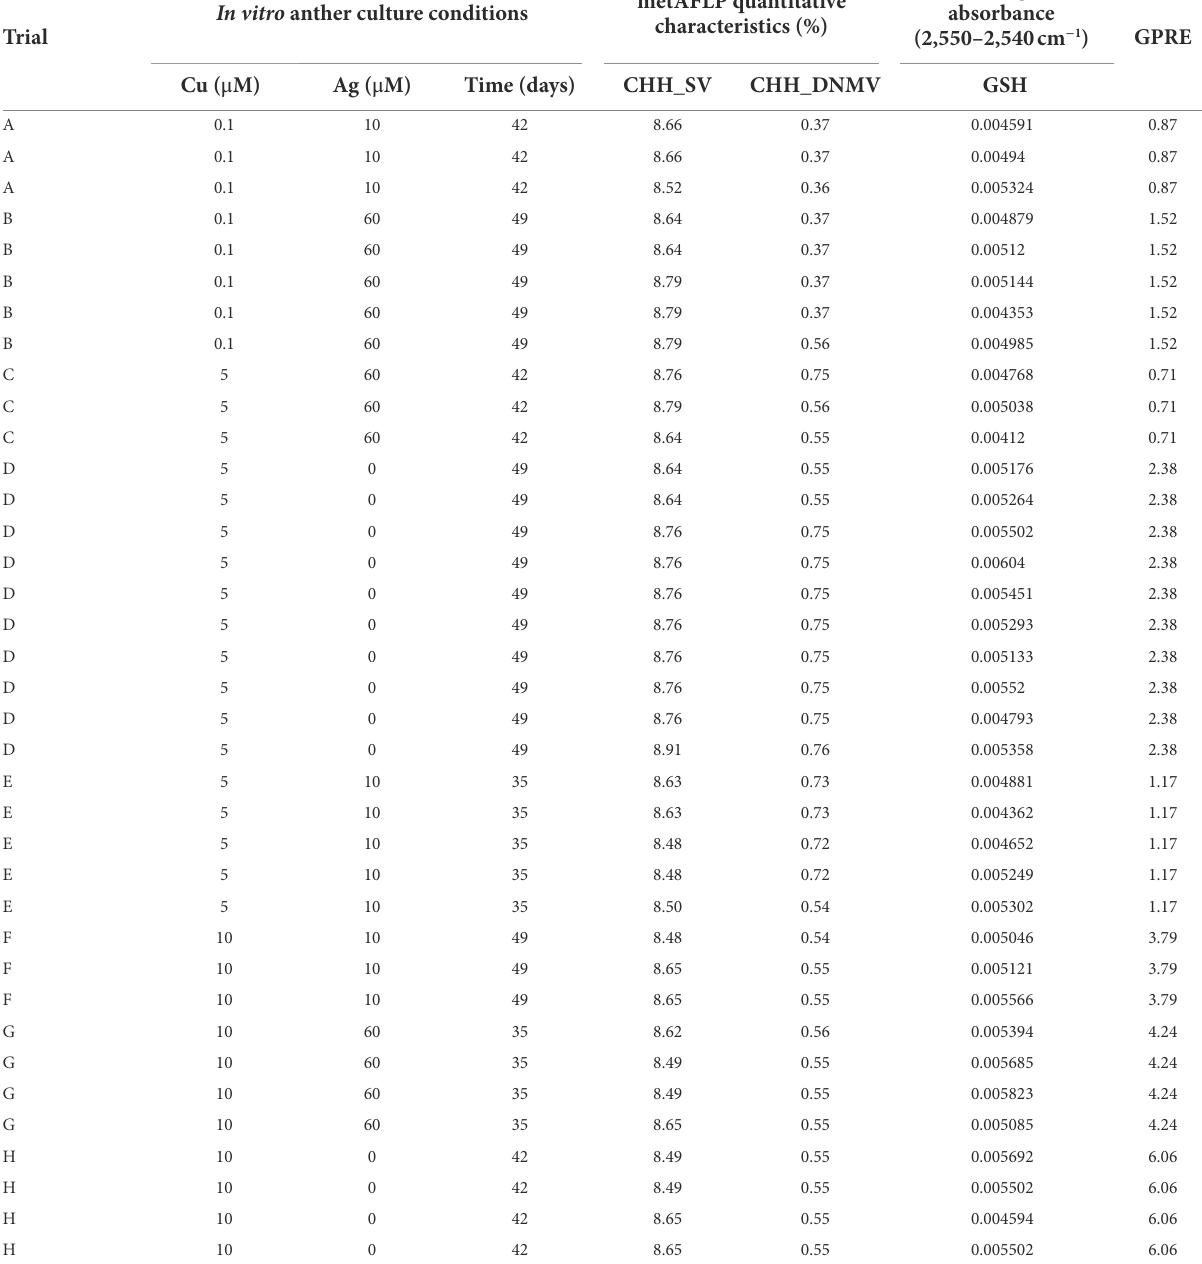
In vitro anther culture